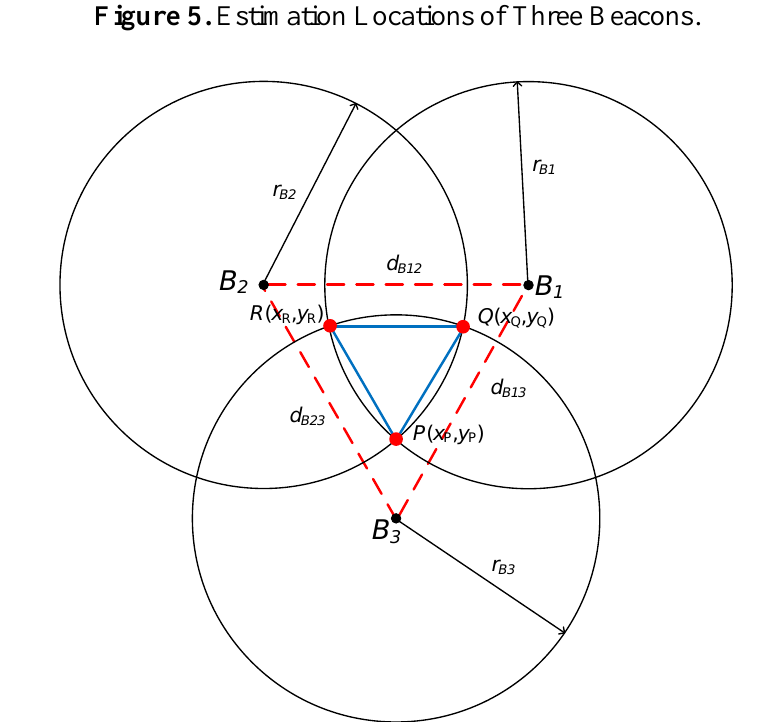
Figure 5. Estimation Locations of Three